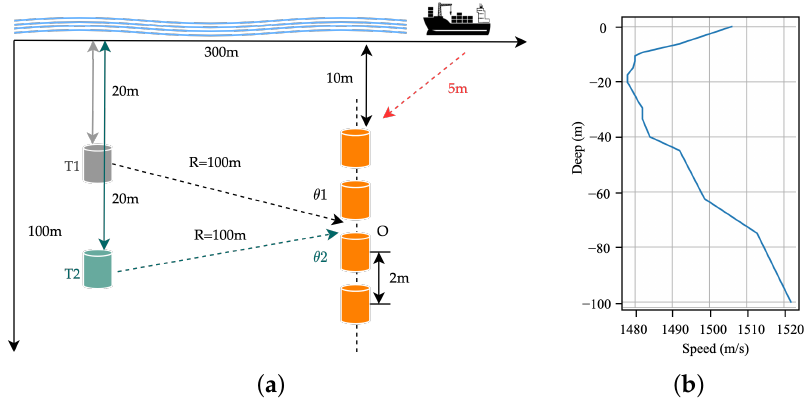
Figure 16. The setup of the simulation test: ( a ) the transmit and receive settings for the simulation environment; ( b ) the sound velocity profile.